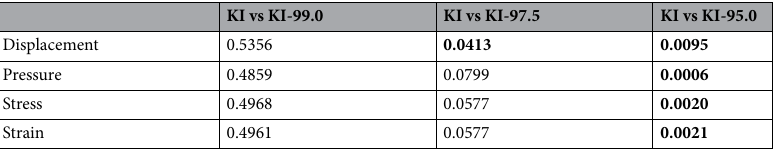
Table 1. Left femur dataset summary of t test results from analyses of biomechanical data between the different segmentation experimental groups. p values shown. Statistical significance indicated in bold.